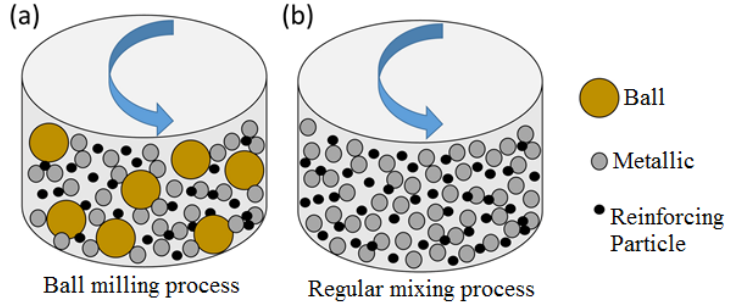
Figure 3. Schematic of: ( a ) ball milling and ( b ) regular mixing processes as the mechanical methods of producing composite powder for the SLM process [52].